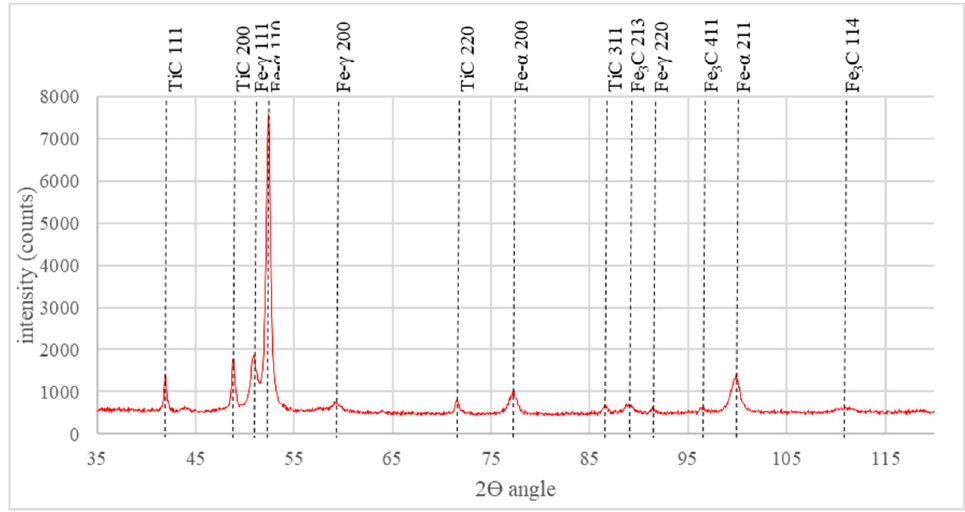
Figure 6. The XRD pattern of surface layer alloyed with 2000 W laser beam, 0.075 speed and 12 mg/mm Ti powder feed rate.